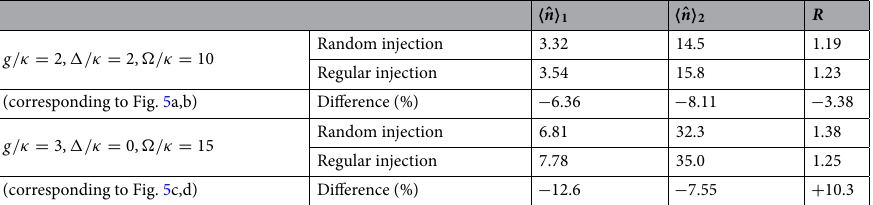
Table 1. Random vs. regular injection cases. The comparison of mean photon numbers in the random- and regular injection cases under two different conditions of Fig. 5. The percentage difference is defined as the quantity in the random injection divided by that in the regular injection minus